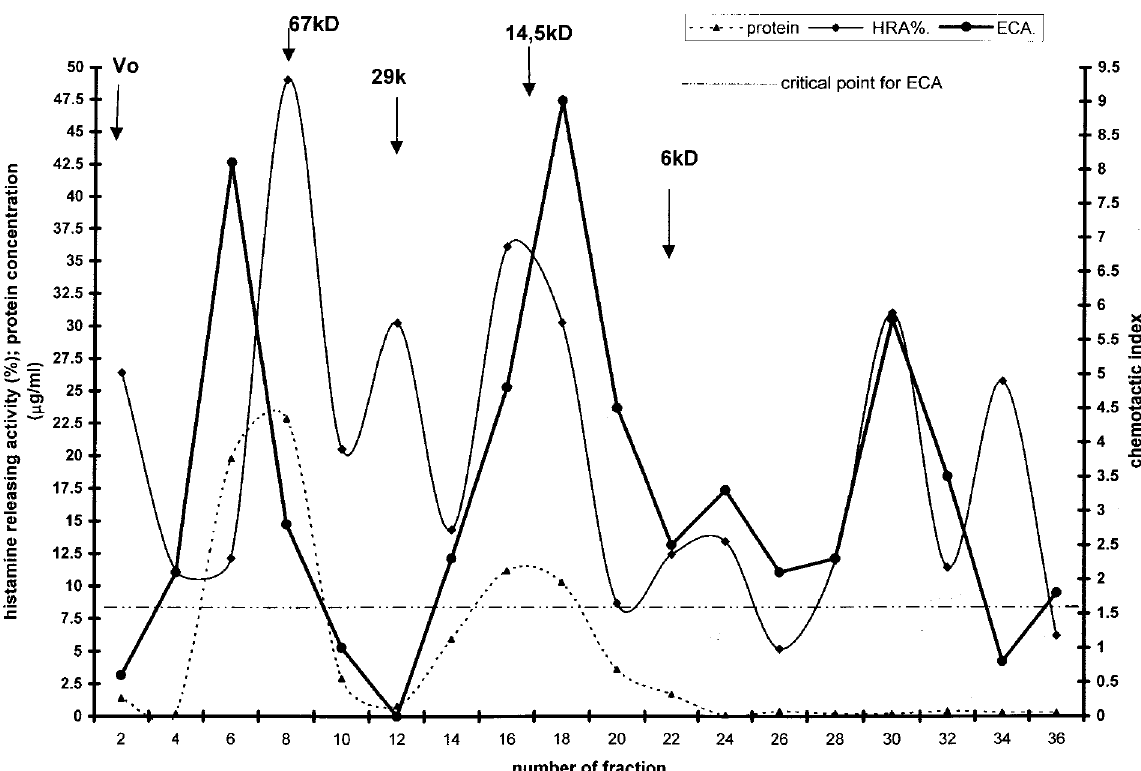
FIG. 4. Gel column chromatography analysis of ECA and HRA generated by mononuclear cells from healthy subjects (supernatants polled from three